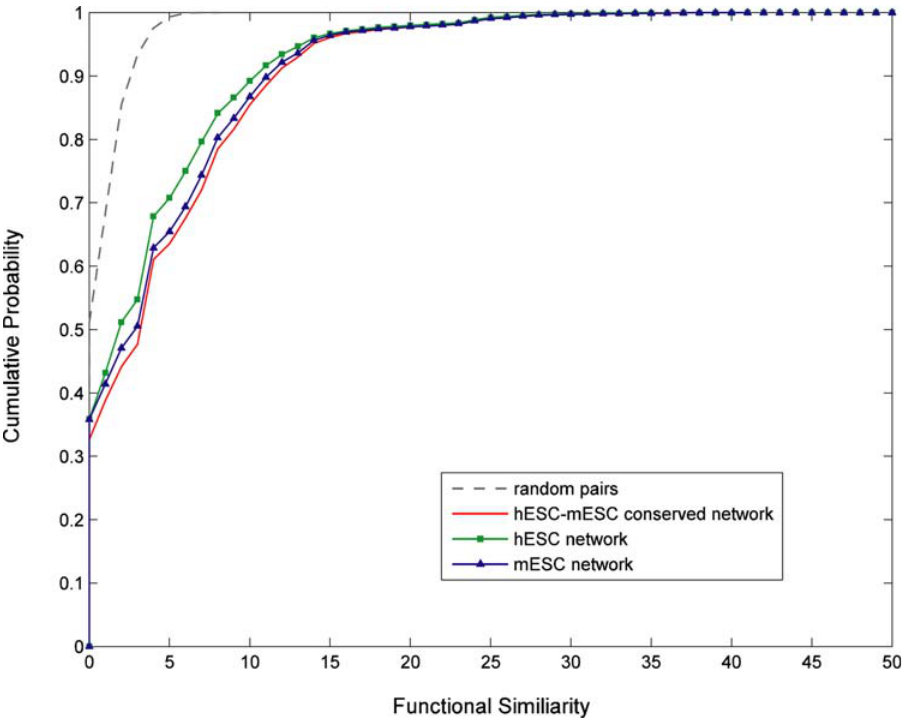
Figure 4. Cumulative distributions of functional similarities for co-expressed genes in ESC co-expression networks and random gene pairs. The functional similarity was calculated based on the Gene Ontology terms from a ) 624,491 and 637,009 pairs of co-expressed genes in hESC and mESC networks, respectively (shown as the square-dotted/green, or triangle-dotted/blue solid lines, respectively, on the graph), b ) 55,712 pairs of co-expression genes in the hESC-mESC conserved network (non-dotted/red line), and c ) 250,000 randomly selected gene pairs (dash or grey line). For the random gene pairs, the functional similarity was 8 when the cumulative probability reached 1 ( i.e. all genes were analyzed). For the co- expressed gene pairs in hESC, mESC, and hESC-mESC conserved networks, the functional similarity was over 30 when the cumulative probability reached 1. The cumulative distributions of functional similarities from the co-expressed genes were significantly different from that of the random gene pairs (P , 10 2 10 by the Kolmogorov-Smirnov test). The co-expressed genes in the hESC-mESC conserved network exhibited a higher functional similarity than the hESC or mESC network (P , 10 2 10 by the Kolmogorov-Smirnov test on the distributions). doi:10.1371/journal.pone.0003406.g004 PLoS ONE |